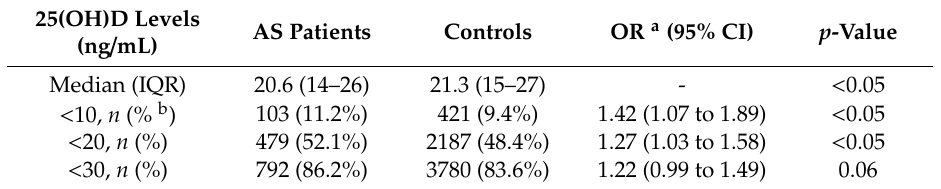
Table 2. 25-hydroxyvitamin-D (25[OH]D) levels and rates of vitamin D deficiency in ankylosing spondylitis (AS) patients compared to